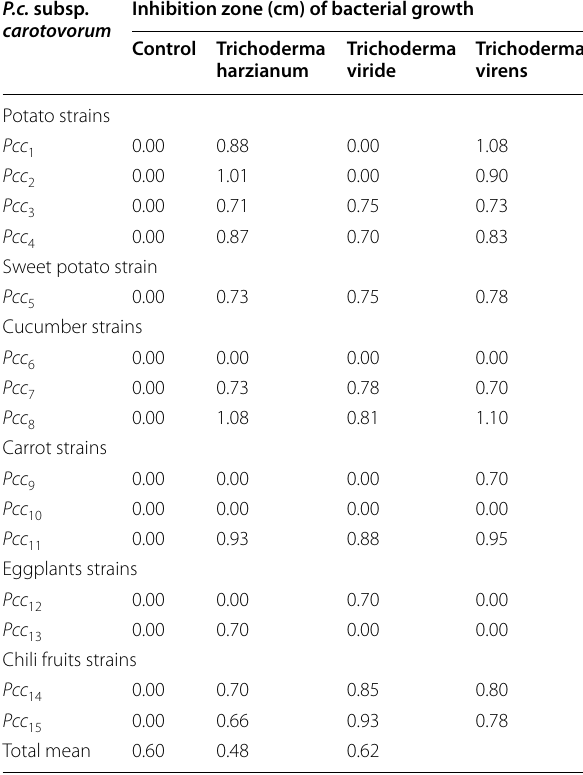
filtrates of fungal agents against the bacterial growth of Pectobacterium carotovorum subsp. carotovorum strains in vitro